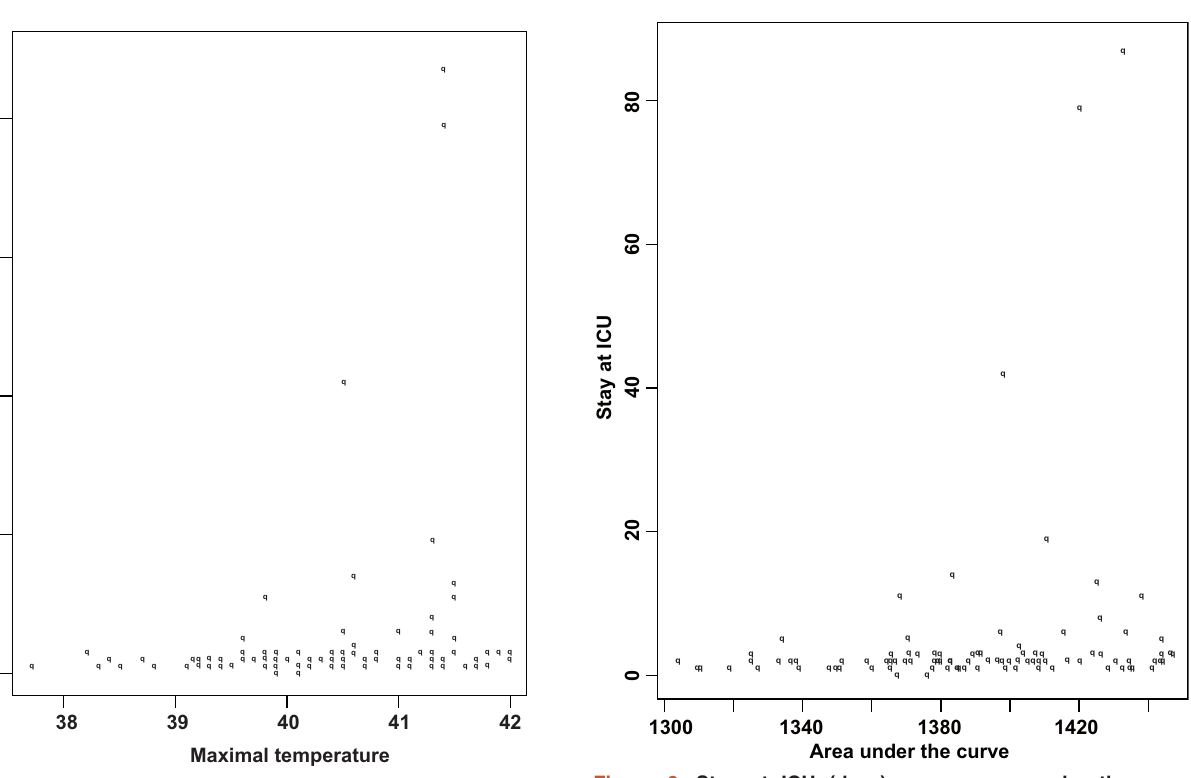
Figure 8. Stay at ICU (days) versus area under the curve ( ° C*minutes). Scatterplot showing the relation between stay at ICU and